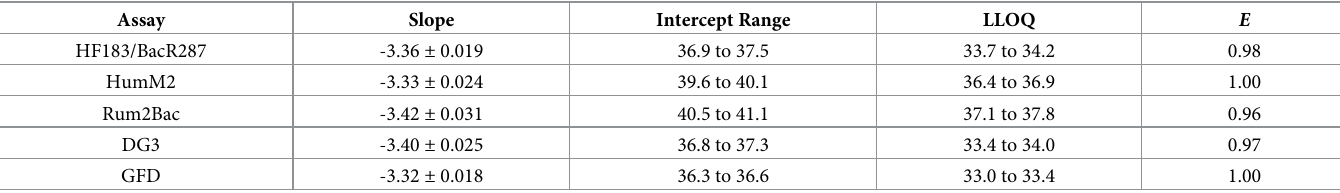
Table 3. Calibration model performance metrics.